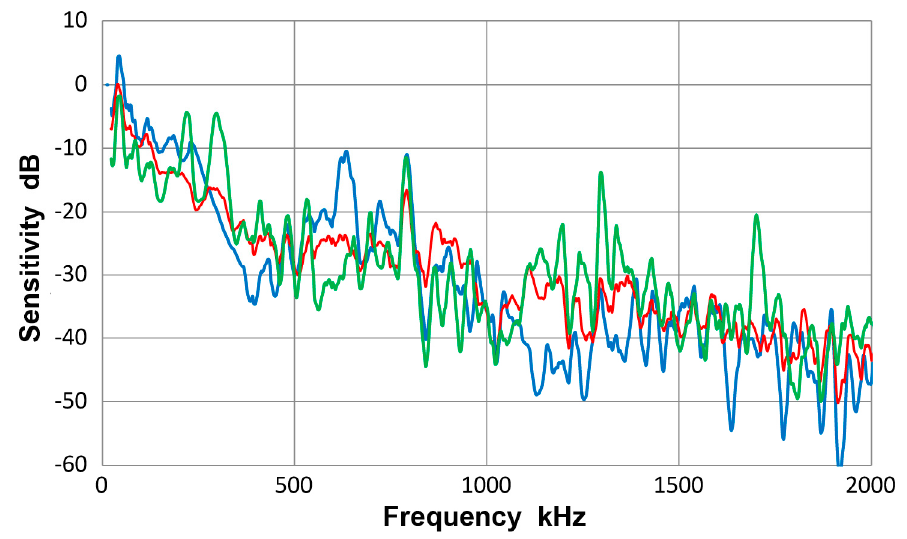
Figure A3. Receiving sensitivity of Olympus V103 transducer. Red -averaged guided wave sensitivity, blue -Lamb waves from symmetric excitation for 6.4 mm plate, green -Lamb waves from asymmetric excitation for the same plate.